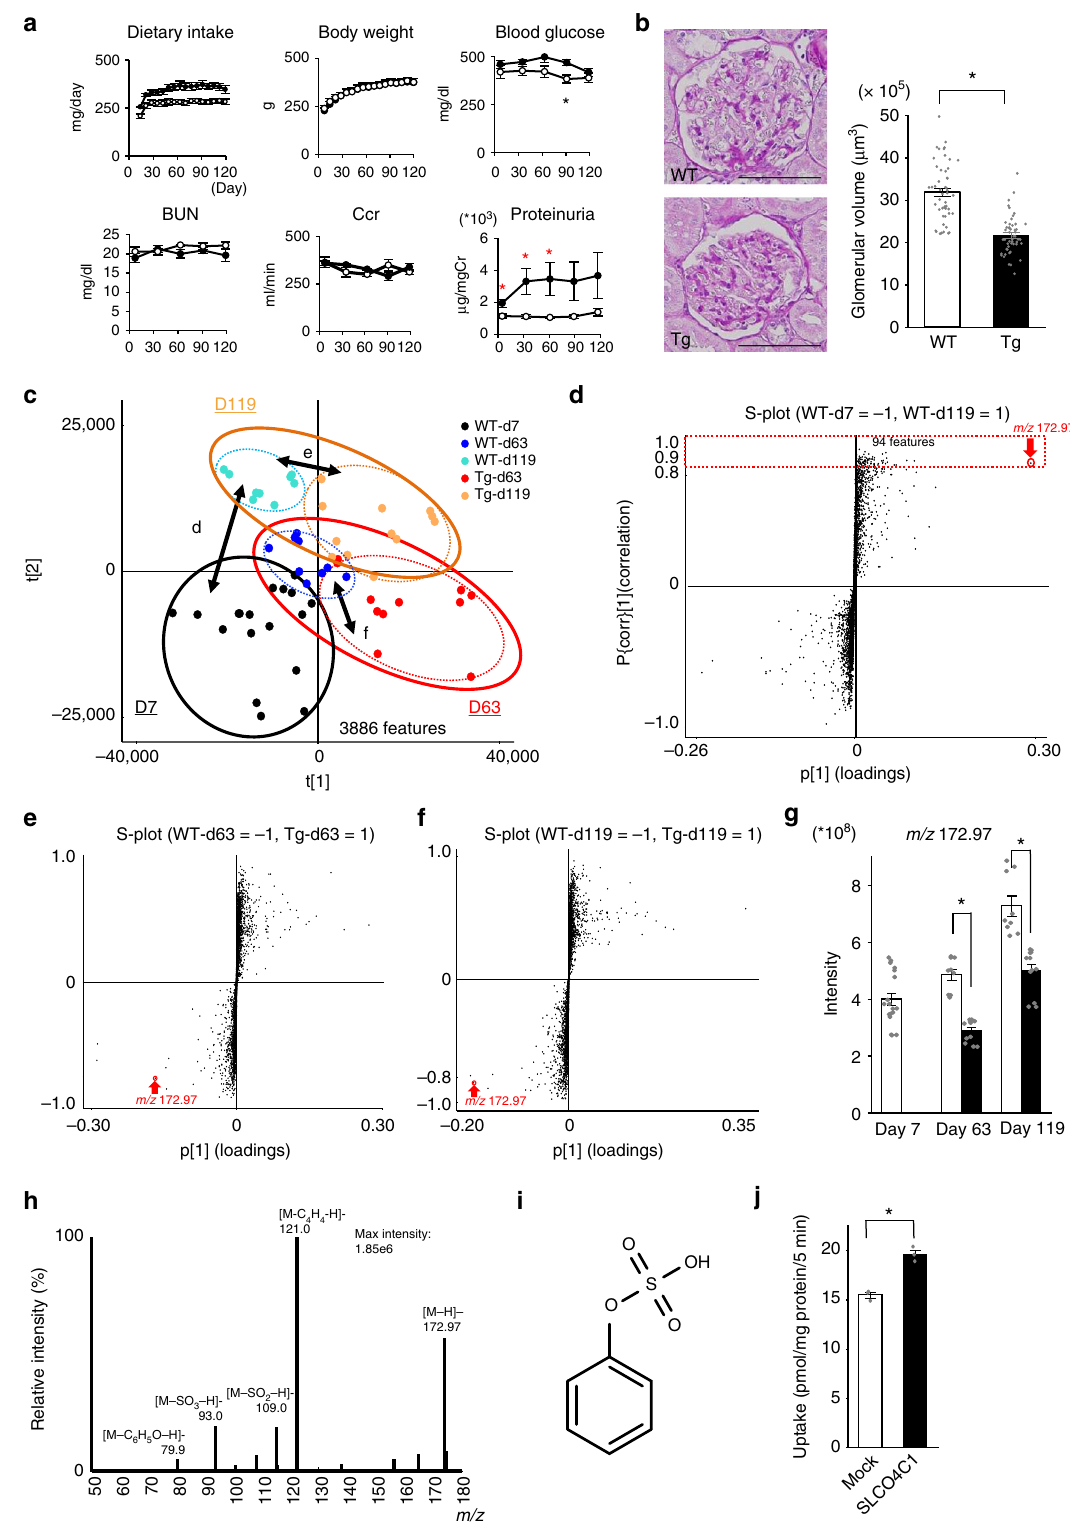
PS (Fig. 1i), which provided a similar fragmentation pattern and retention time. The plasma PS levels measured precisely by liquid chromatography (LC)/MS/MS 8 in WT-DM rats on days 63 and 119 were 4.47 ± 0.43 and 6.48 ± 0.71 μ M, respectively, and these levels were decreased in Tg-DM rats (Supplementary Fig. 3). To con fi rm whether PS is a substrate of SLCO4C1, an uptake study